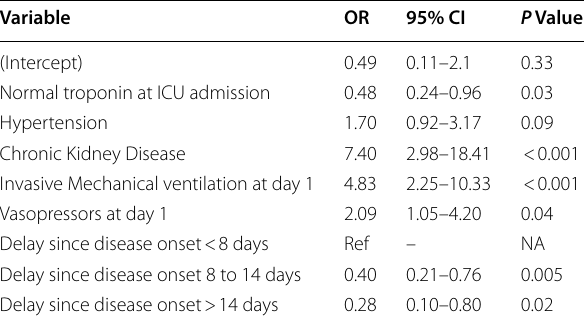
Table 2 Mixed logistic regression assessing risk factors of AKI